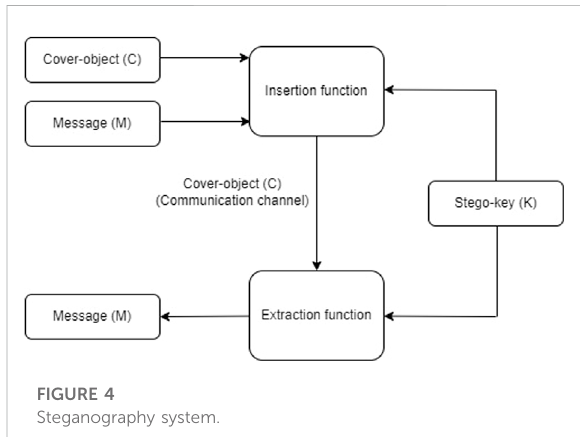
FIGURE 4 Steganography